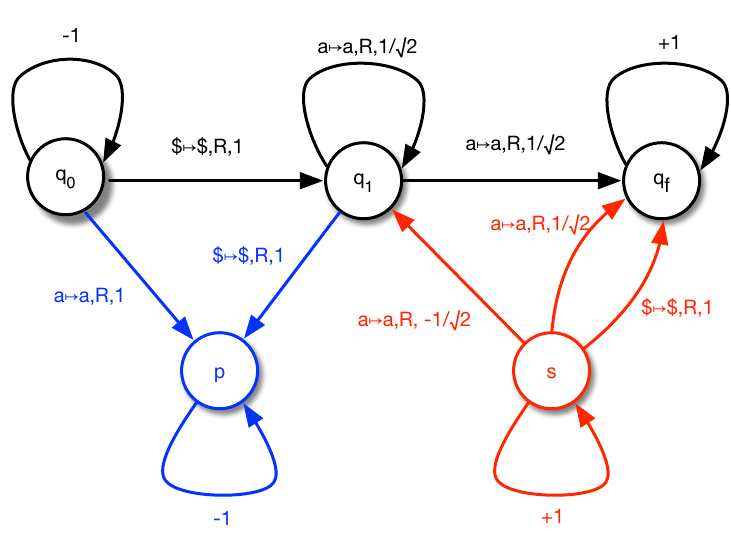
Figure 4. A QTM computing the successor function (the identity w.r.t. the tape) as a